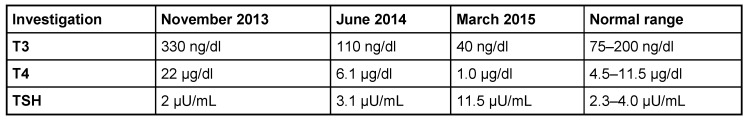
Thyroid profile